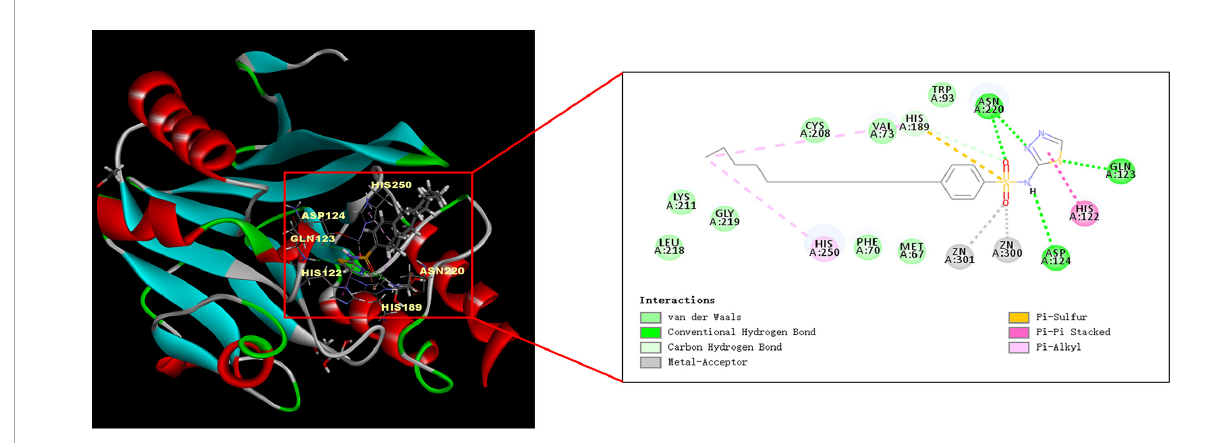
FIGURE3 Molecular docking of NDM-1 and PHT427. The active pocket of NDM-1 bound to PHT427.